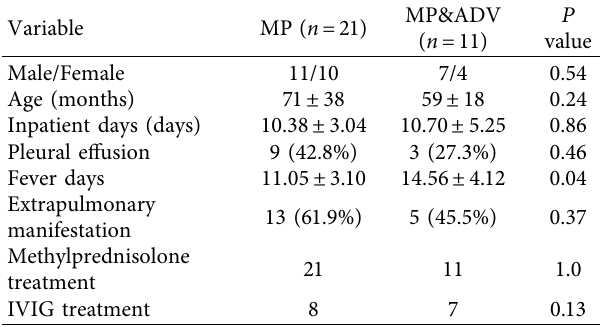
Table 1: Demographical characteristics.